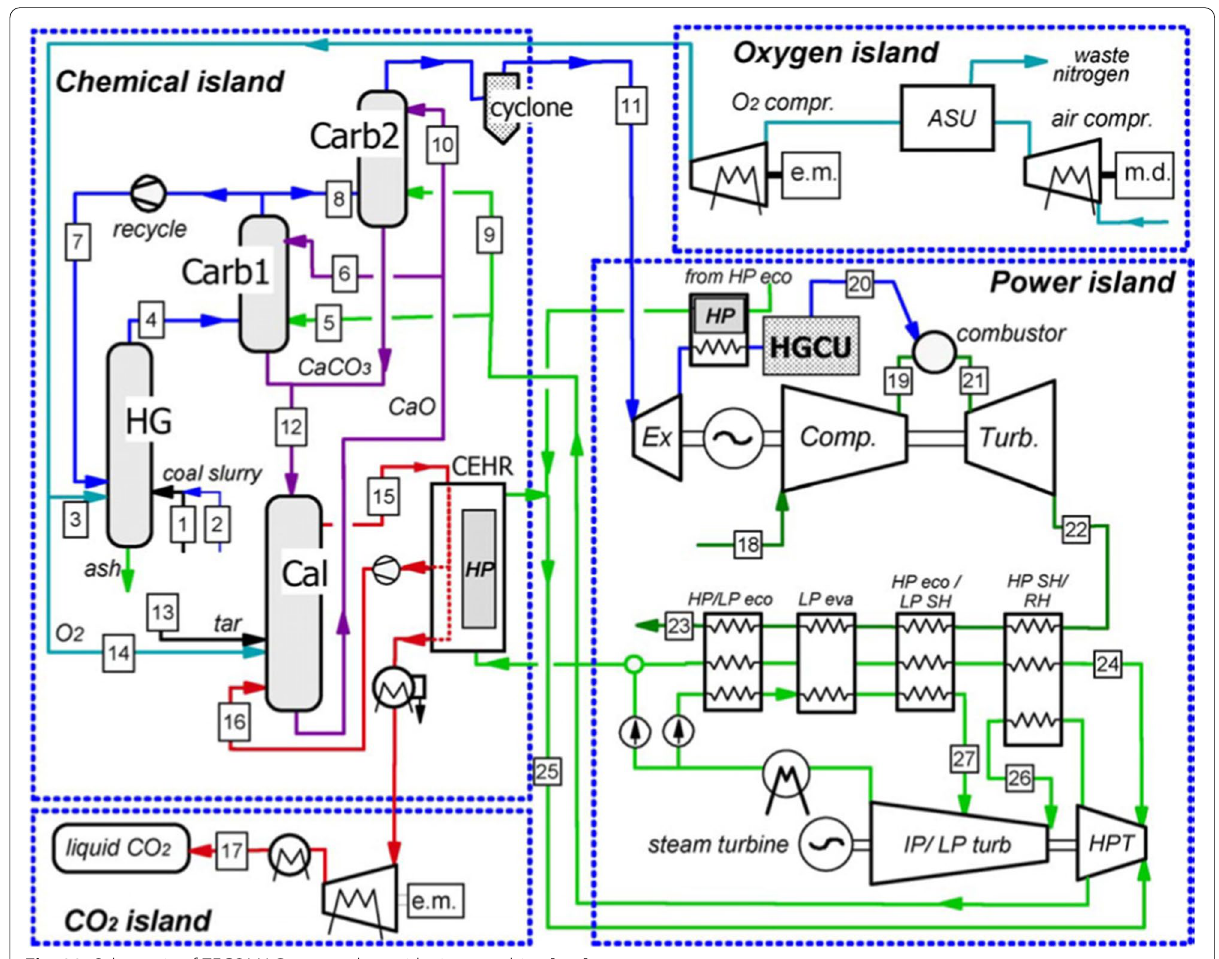
Fig. 22 Schematic of ZECOMAG power plant with air gas turbine